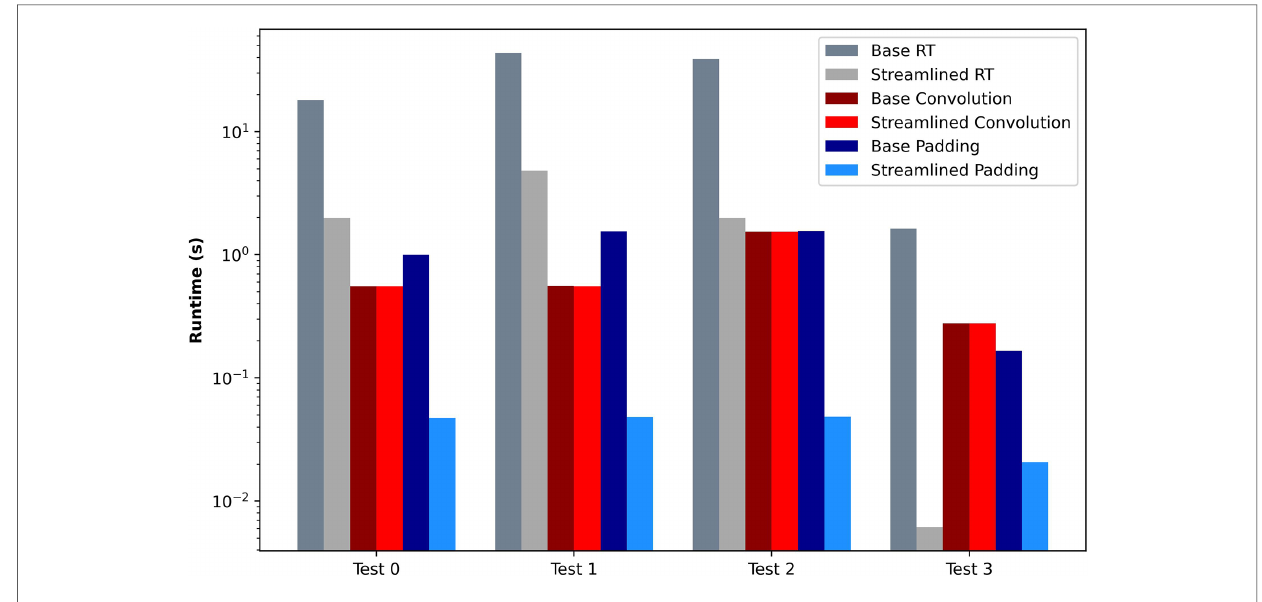
FIGURE 5 Convolution Performance Evaluation between Streamlined and Baseline approaches to algorithms.